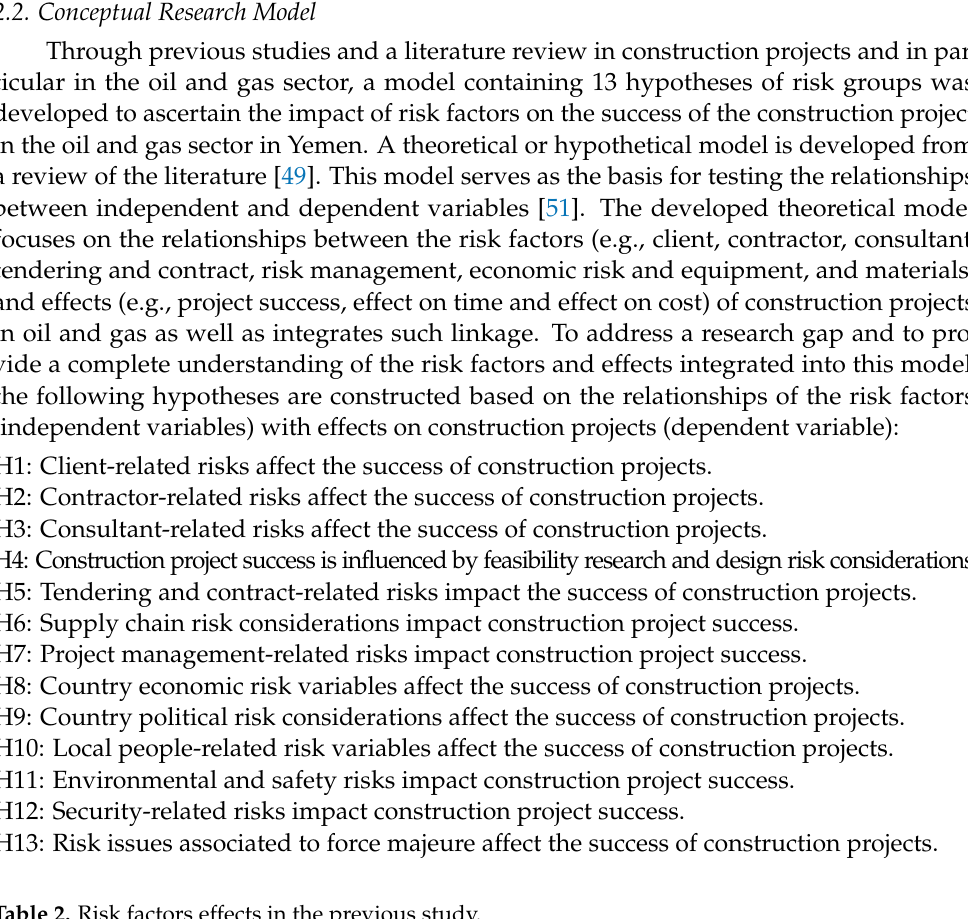
Table 2. Risk factors effects in the previous